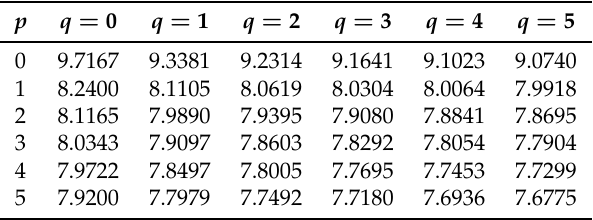
Table A3. Conditional entropies H ( p , q ) (bits/pixels), computed for various values of p and q , over